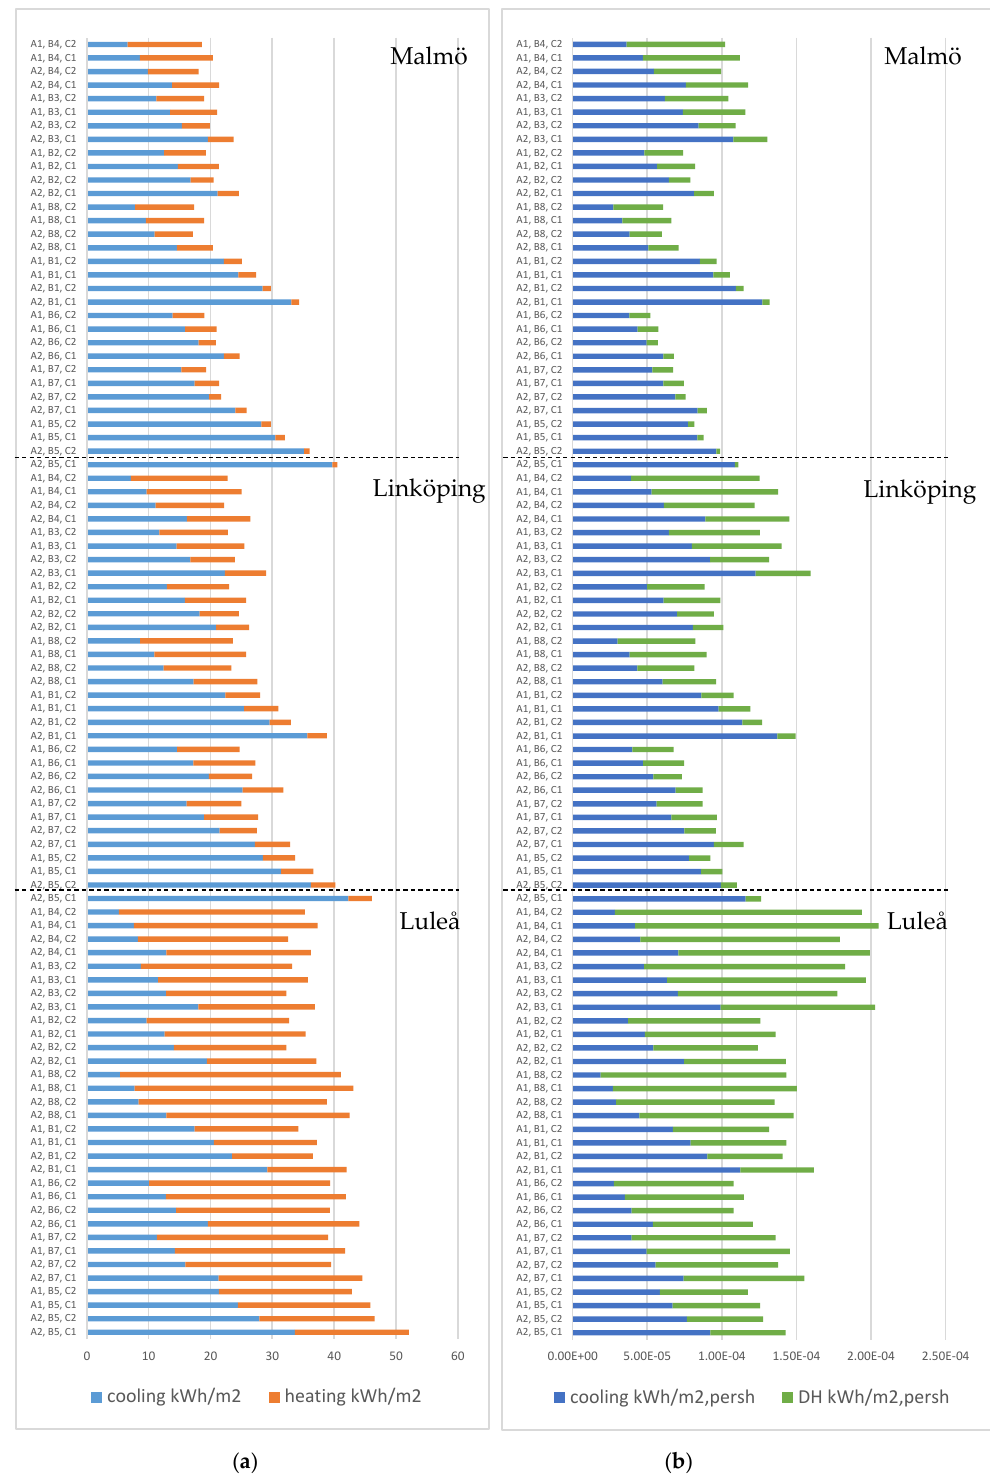
Figure 8. ( a ) Heating and cooling demand for all cases with indicator kWh / m 2 , year, ( b ) heating and cooling demand with indicator kWh / m 2 , hours of occupancy and year. Internal gains B1–B8 is ordered from the lowest to highest. A1 is angled façade and A2 is straight façade. C1 is without blinds and C2 is with